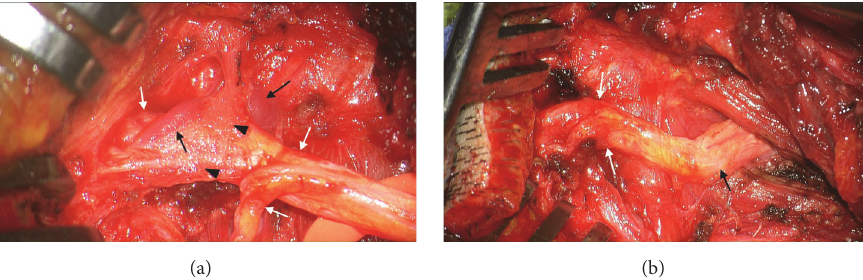
Figure 2: Intraoperative photographs during the decompression of the greater occipital nerve. (a) An intraoperative photograph showing adhesions of the greater occipital nerve (white arrows) with the connective tissue (black arrow heads) and occipital arteries (black arrows) . (b) An intraoperative photograph after decompression of the left greater occipital nerve. A reddish deformation is apparent in the compressed portion (white arrows) with pathological vascular contact compared to the normal proximal course (black arrow) of the greater occipital